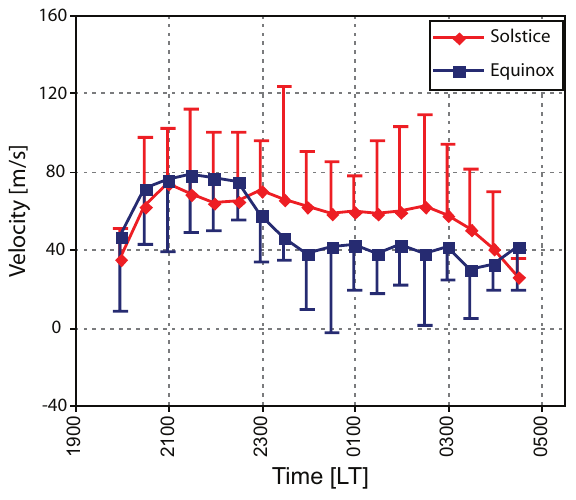
Fig. 5. Comparison of drift velocities during geomagnetically dis- turbed low solar flux